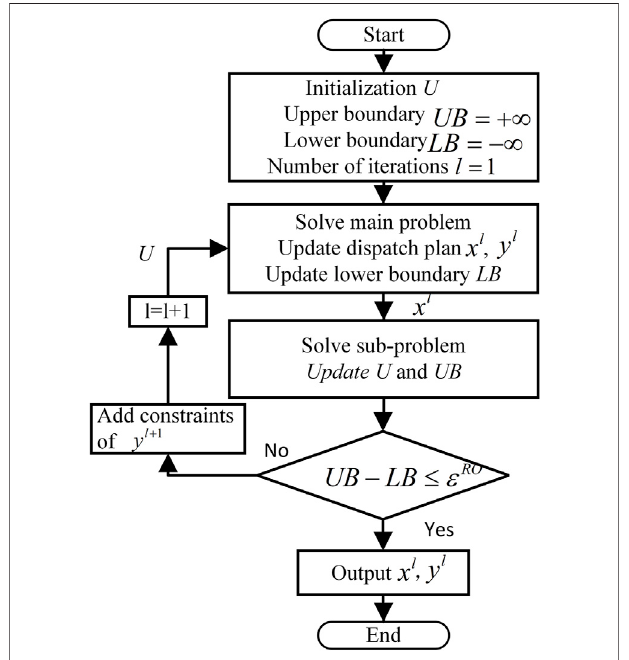
FIGURE 2 | The fl ow of the C&CG method.